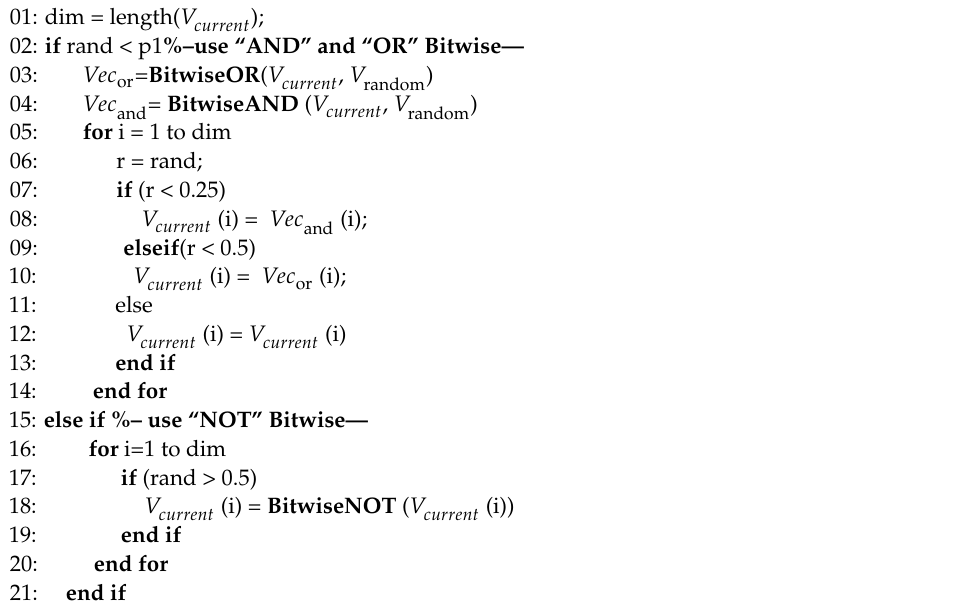
Algorithm 4: Binary Exploration base Bitwise